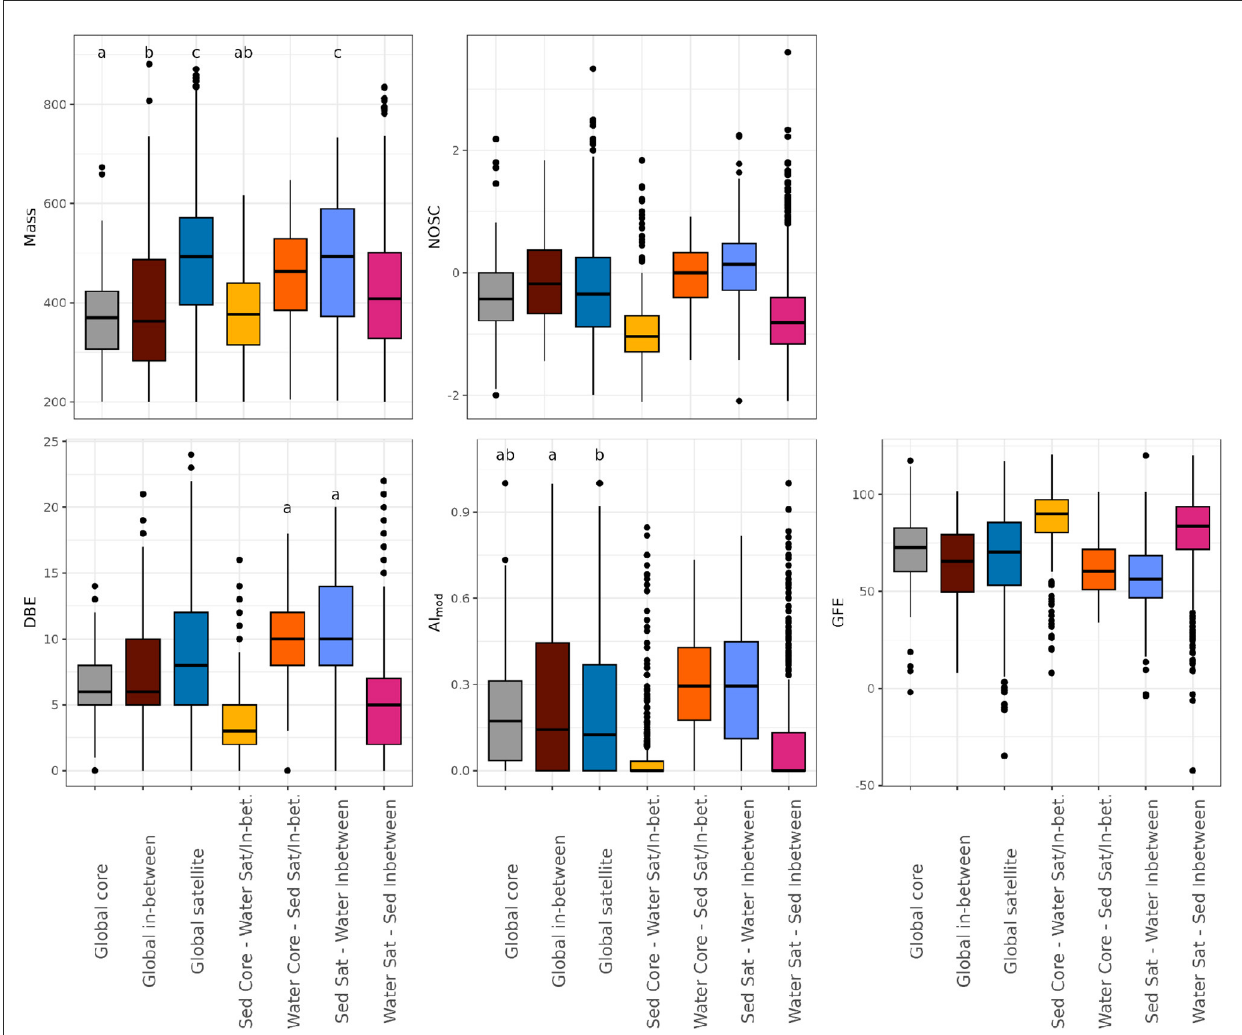
FIGURE4 Chemical properties of dissolved organic matter (DOM)—molecular mass (m/z), nominal oxidation state of carbon (NOSC), double-bond equivalents (DBE), modified aromaticity index (AI mod ), and Gibbs Free energy (GFE; kJ/mol C) —in relation to cross-environment core/satellite-classification. The number of molecular formulae per category is as follows (see also Table S3): global core = 666, global in-between = 543, global satellite = 2,645, sediment core—water satellite/in-between = 524, water core—sediment satellite/in-between = 1,367, sediment satellite—water in-between = 1,151, and water satellite—sediment in-between = 881. Boxplots without identical letters were statistically different from each other (Kruskal-Wallis one-way analysis of variance followed by Dunn’s test). Each boxplot’s upper and lower hinges correspond to the first and third quartiles, respectively. The whiskers extend from the hinge to the largest and smallest value within 1.5 times the interquartile range. Data beyond whiskers are displayed as outlier